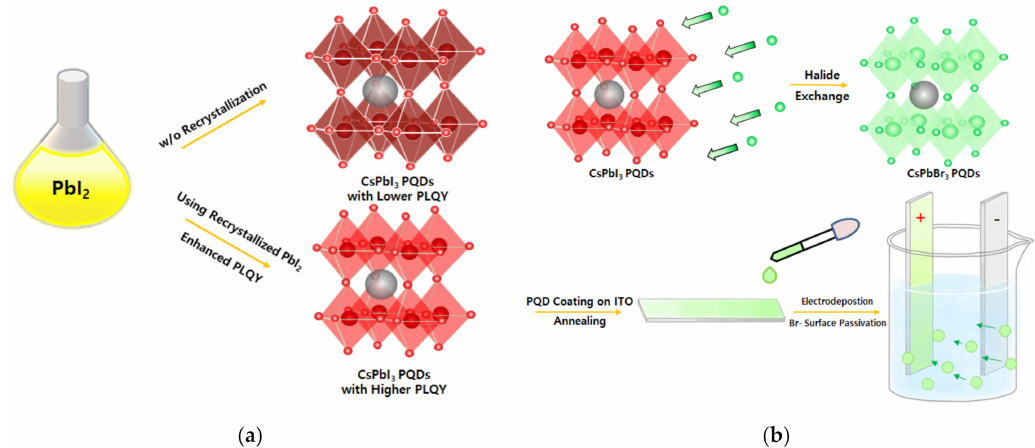
Scheme 1. Two different strategies to obtain higher photoluminescence quantum yields. ( a ) With applying recrystallization process of PbI 2 precursor to enhance PLQY of PQDs. ( b ) Halide exchange to form from CsPbI 3 to CsPbBr 3 and subsequent annealing process to adhere CsPbBr 3 on ITO to apply the electrodeposition process to do halide surface defect passivation to decrease surface halide vacancy mediated non-radiative recombination process on the CsPbBr 3 perovskite